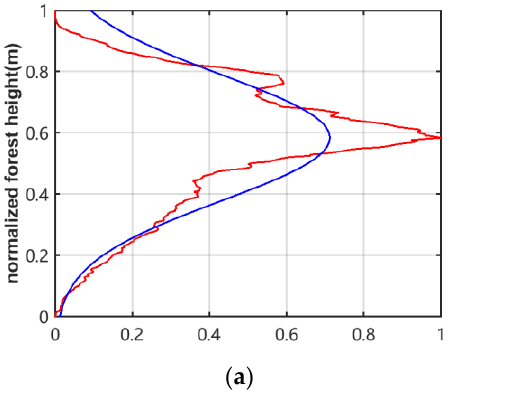
Figure 12. ( a ): Vertical reflectance profile fitted by the InSAR phase center height histogram and Gaussian function. The histogram reflecting the vertical reflectance profile is red, and the vertical reflectance profile obtained by Gaussian function fitting is blue. The vertical axis shows the normalization of the forest heights ranging from 0 to 1 m. ( b ): Change in the magnitude of the influence factor 𝑎 for different extinction coefficients, which determine the shape of the curve. The curves of 0.2, 0.5 and 1 for 𝑎 are indicated in blue, red and green, respectively, and the 𝑎 value obtained by fitting the Gaussian function is yellow.